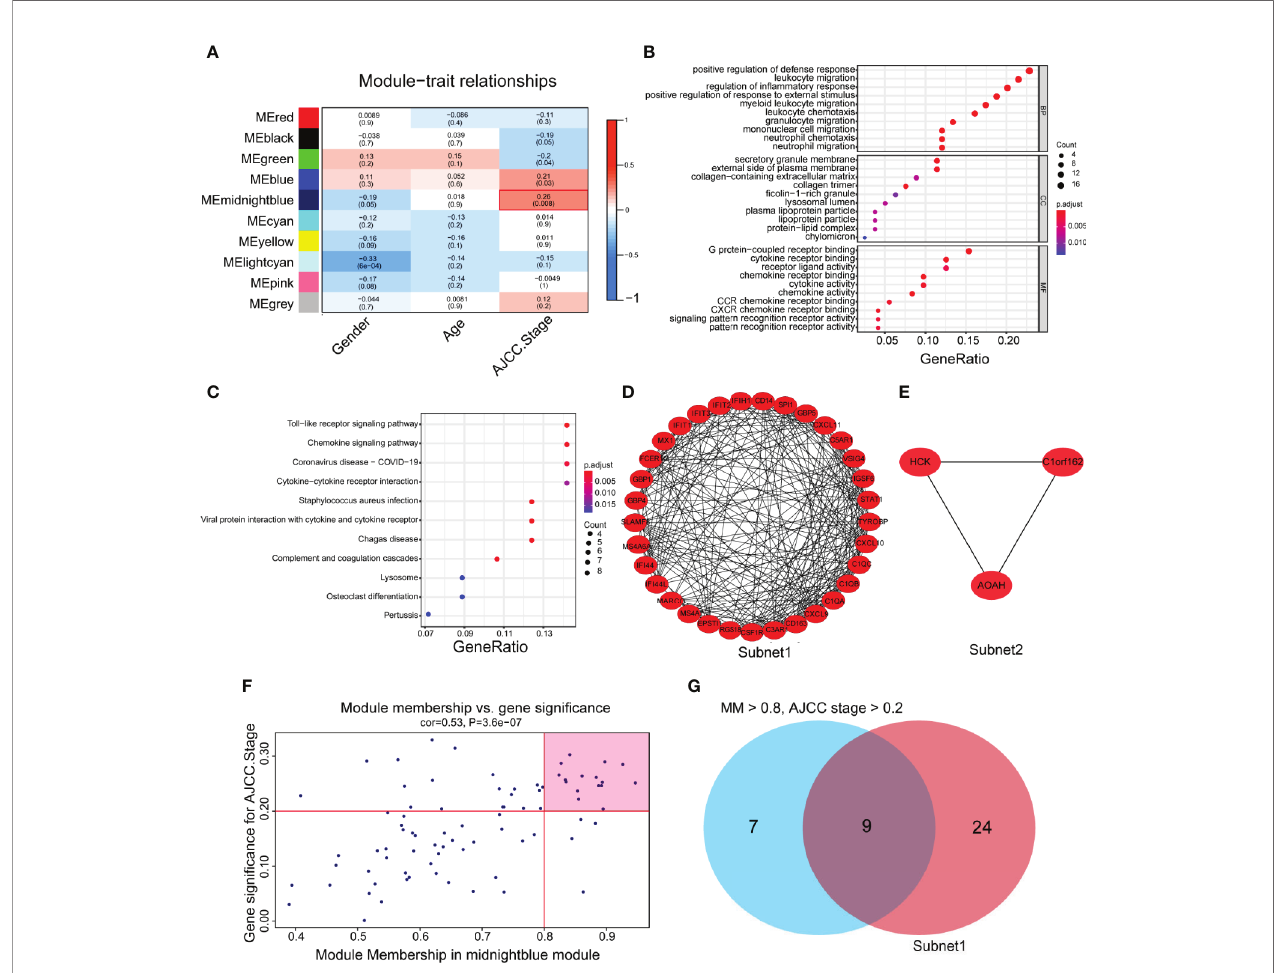
FIGURE 2 | The identi fi cation of hub genes related to gastric cancer progression. (A) Heatmap of the correlations between module eigengenes and the clinical traits of gastric cancer. (B) Gene Ontology (GO) analysis of the genes in the midnight blue module (p < 0.05). (C) Kyoto Encyclopedia of Genes and Genomes (KEGG) analysis of the genes in the midnight blue module (P < 0.05). (D, E) Protein-protein interaction (PPI) core network of subnet 1 (MCODE score = 15.1) and subnet 2 (MCODE score = 3.0) in the midnight blue module. (F) Scatter plot genes in the midnight blue module. The vertical line represents the cutoff of module membership = 0.8, and the horizontal line represents the cutoff of gene signi fi cance for AJCC stage = 0.2. (G) The Venn diagram shows the intersection of the MCODE core network and the module membership (>0.8) and the signi fi cance of correlations with AJCC stage (>0.2) genes in the